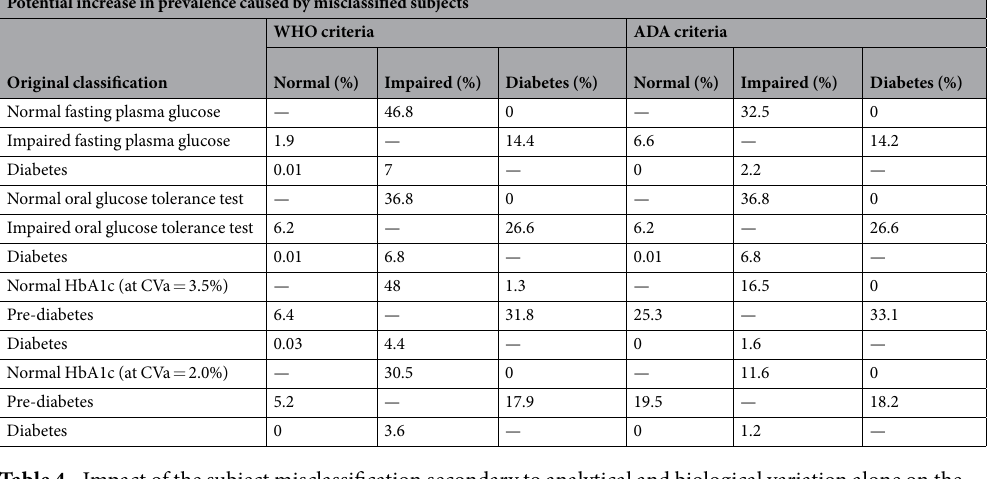
Table 4. Impact of the subject misclassification secondary to analytical and biological variation alone on the potential increase in the prevalence of various diagnostic categories. This is calculated by using the dividing the number of misclassified subjects with the original number of subjects within each diagnostic